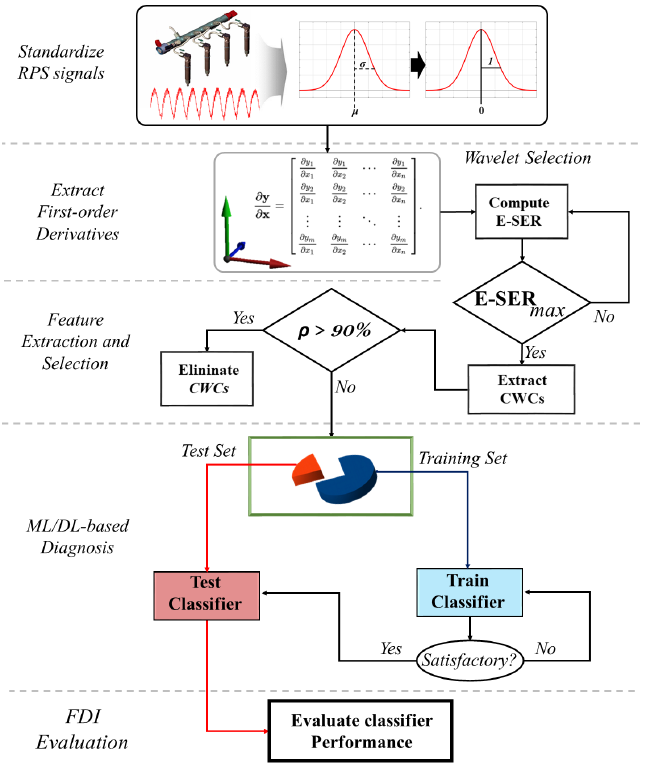
Figure 3. Proposed diagnostic